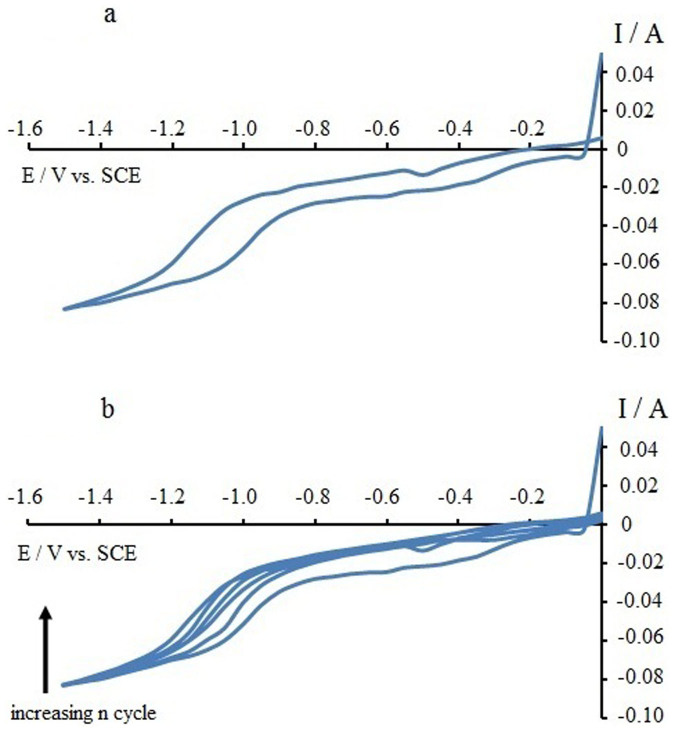
The CV for the electrochemical reduction of GO onto MnO2 substrate, (a) first cycle (b) all four cycles.